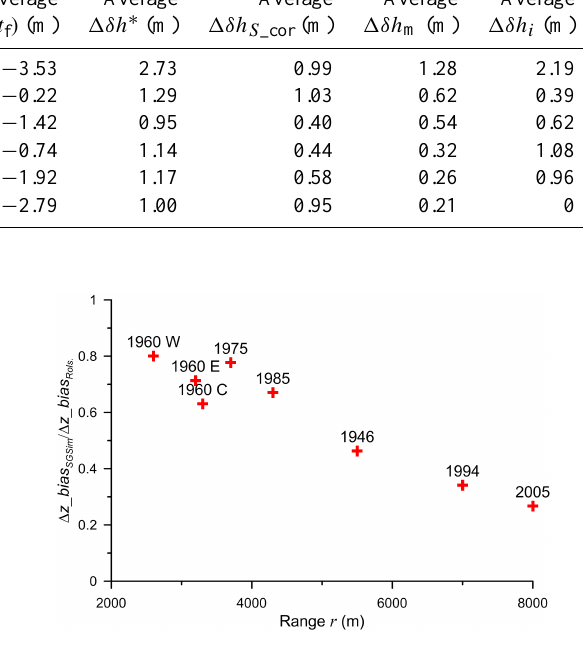
Figure 8. The ratio between uncertainties (95% confidence level) from the methods demonstrated in this work and the method demon- strated by Rolstad et al. (2009) as a function of the range, r , in the deduced spherical semivariogram model. The DEM epoch corre- sponding to each point is shown with a